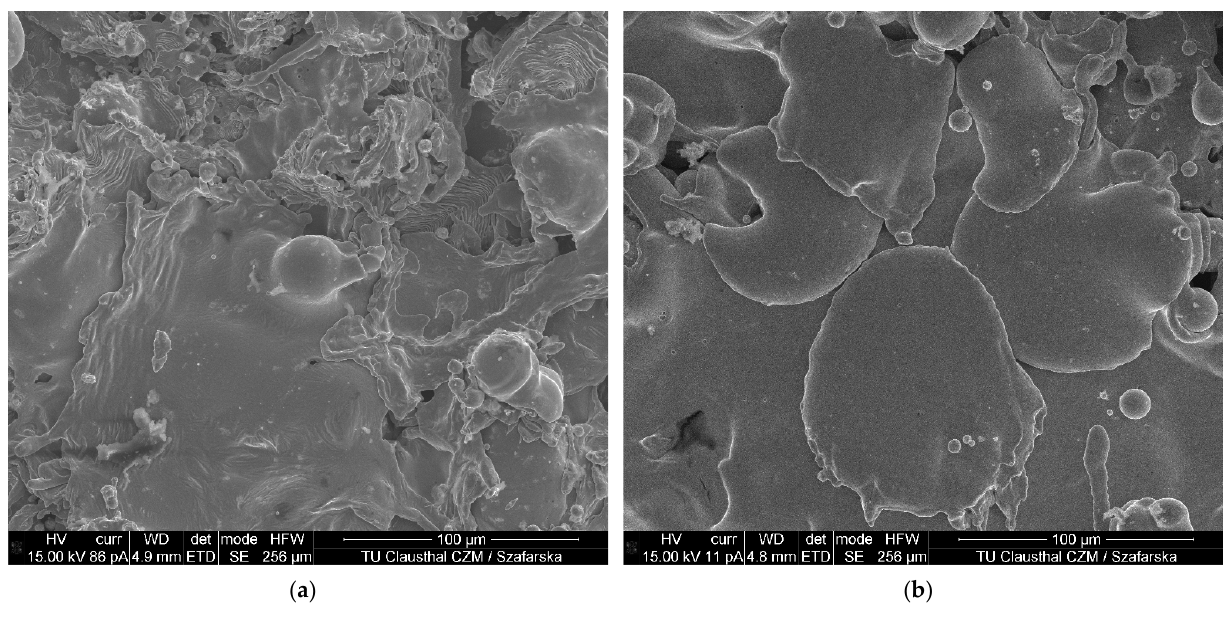
Figure 11. SEM micrographs of wire arc copper coating splats on coating surface: ( a ) conventionally coated in air; ( b ) coated in silane ‐ doped nitrogen.